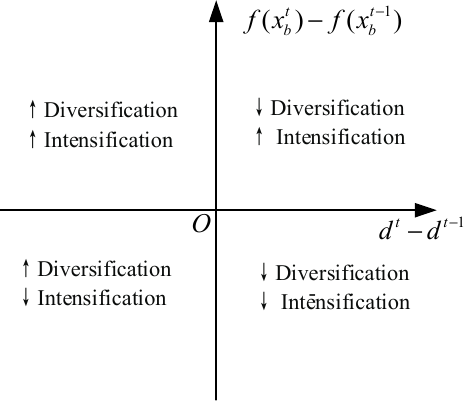
Figure 5. Online learning heuristic selection strategies of swarm hyper-heuristic algorithm.